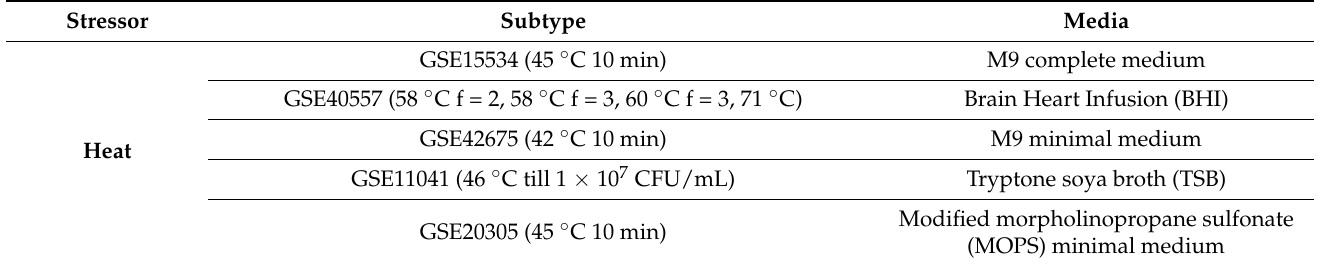
Table 1. Details of stress conditions used in each data